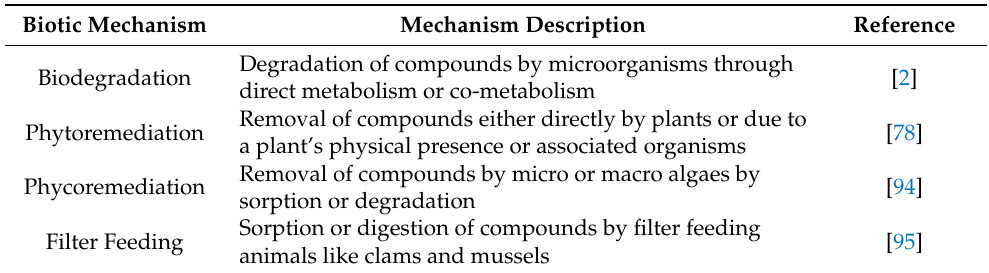
Table 5. Biotic emerging contaminant removal mechanisms in